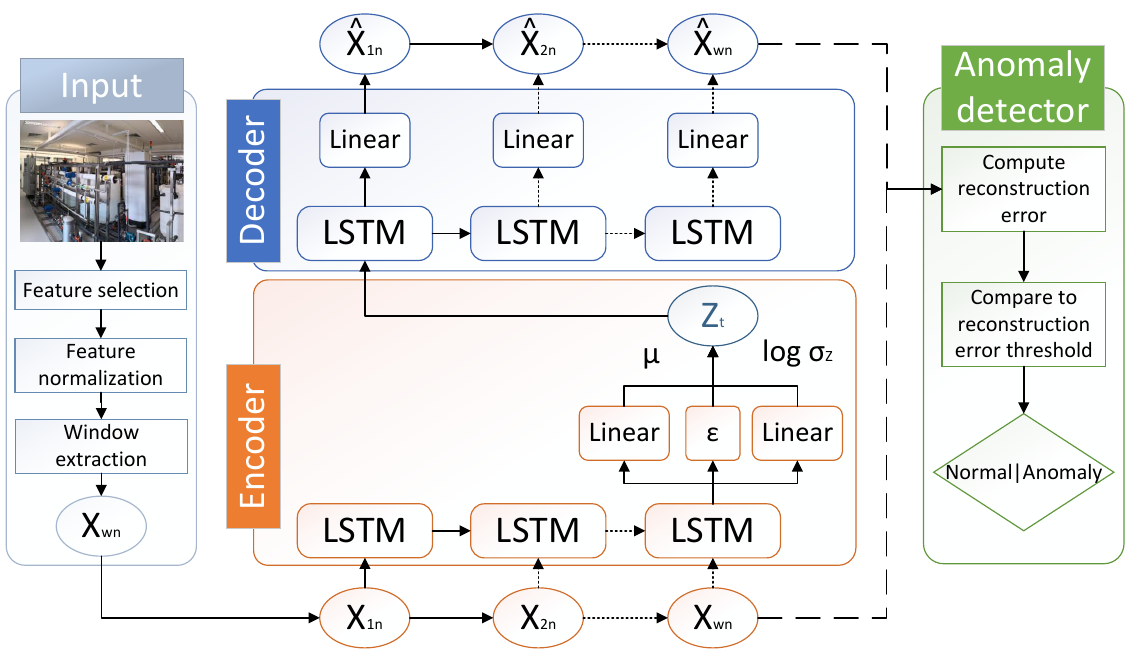
Figure 1. Overview of the methodology proposed in this work. The methodology consits of 3 phases: the input phase (grey), the reconstruction phase (orange, blue), and the anomaly detection phase